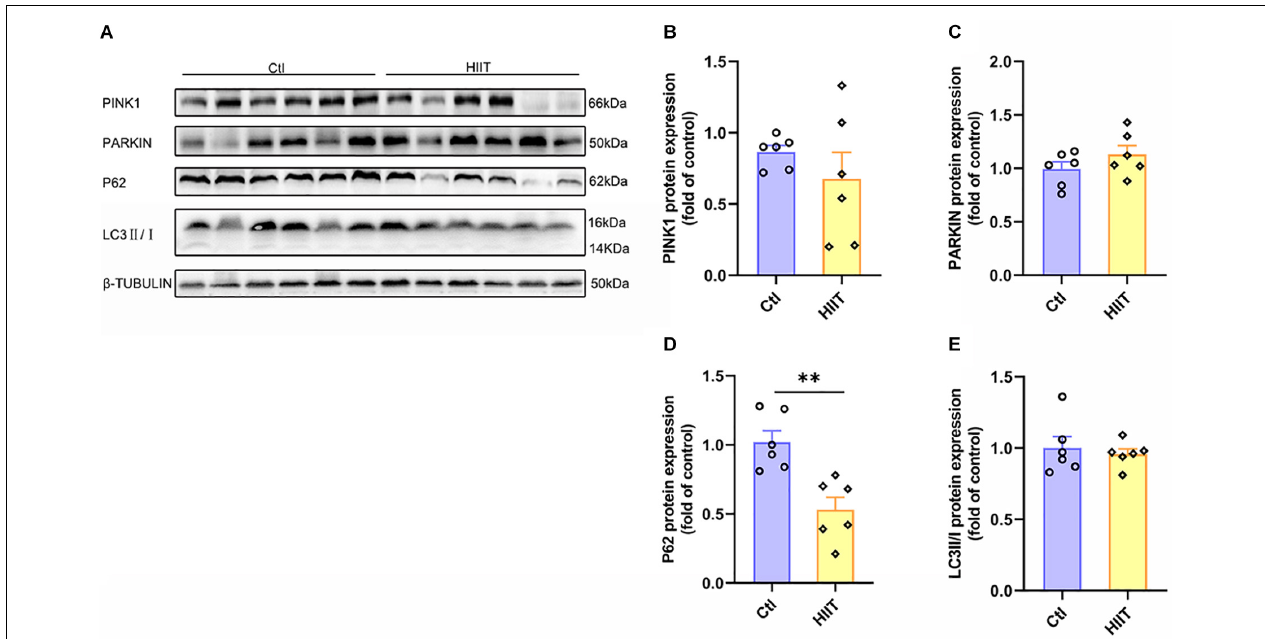
FIGURE 5 | The effects of HIIT on hippocampal mitophagy. The PTEN-induced putative kinase 1 (PINK1), PARKIN, Sequestosome-1 (P62), and microtubule-associated protein light chain3 (LC3) were determined by WB to represent the mitophagy state in mouse hippocampus. (A) Representative WB image. (B) PINK1 protein expression. (C) PARKIN protein expression. (D) P62 protein expression. (E) LC3 protein expression. TUBULIN as the loading control. N = 6 mice per group. ∗∗ P ≤ 0.01 as compared with the Ctl group by unpaired Student’s t test. Values are expressed as mean ± standard error of the